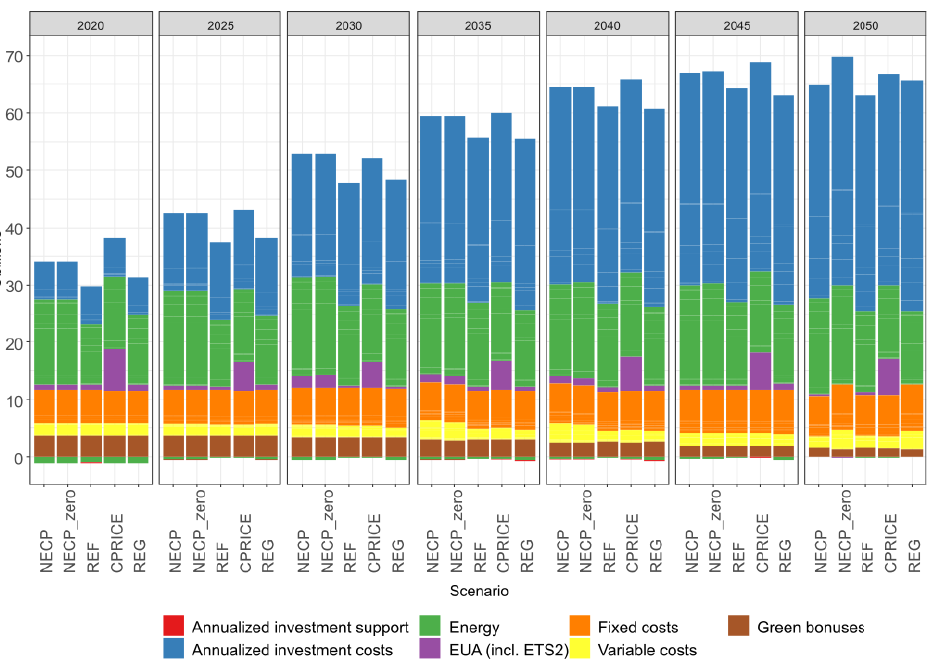
Figure 12. Annualized system cost (EUR 2020, without VAT).